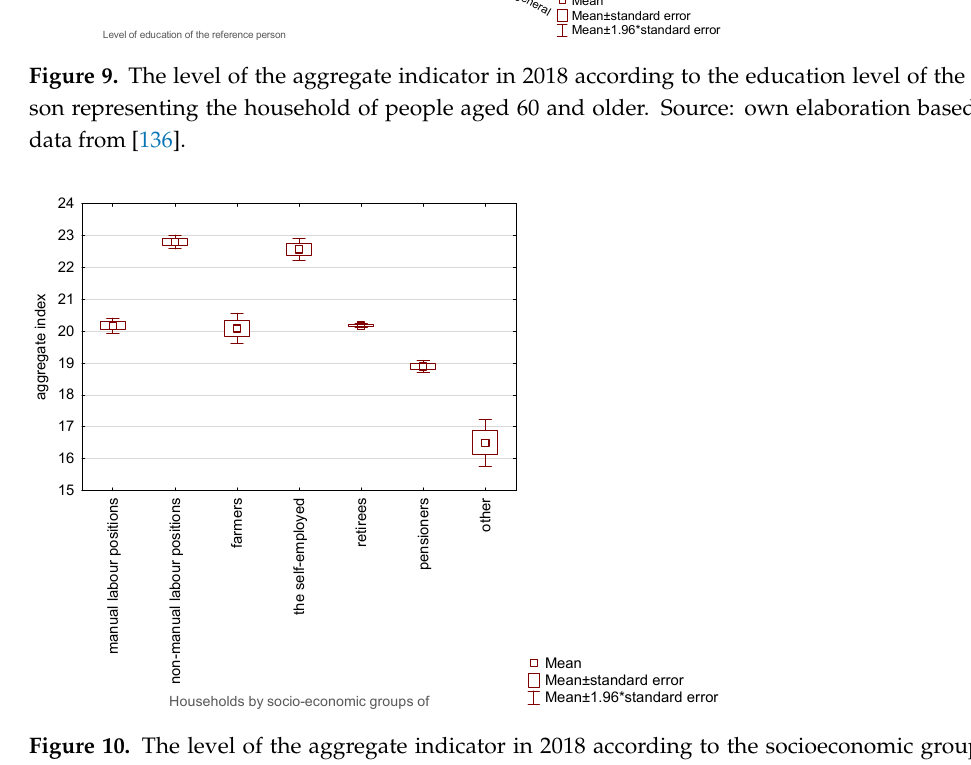
Figure 9. The level of the aggregate indicator in 2018 according to the education level of the person representing the household of people aged 60 and older. Source: own elaboration based on data from [136].